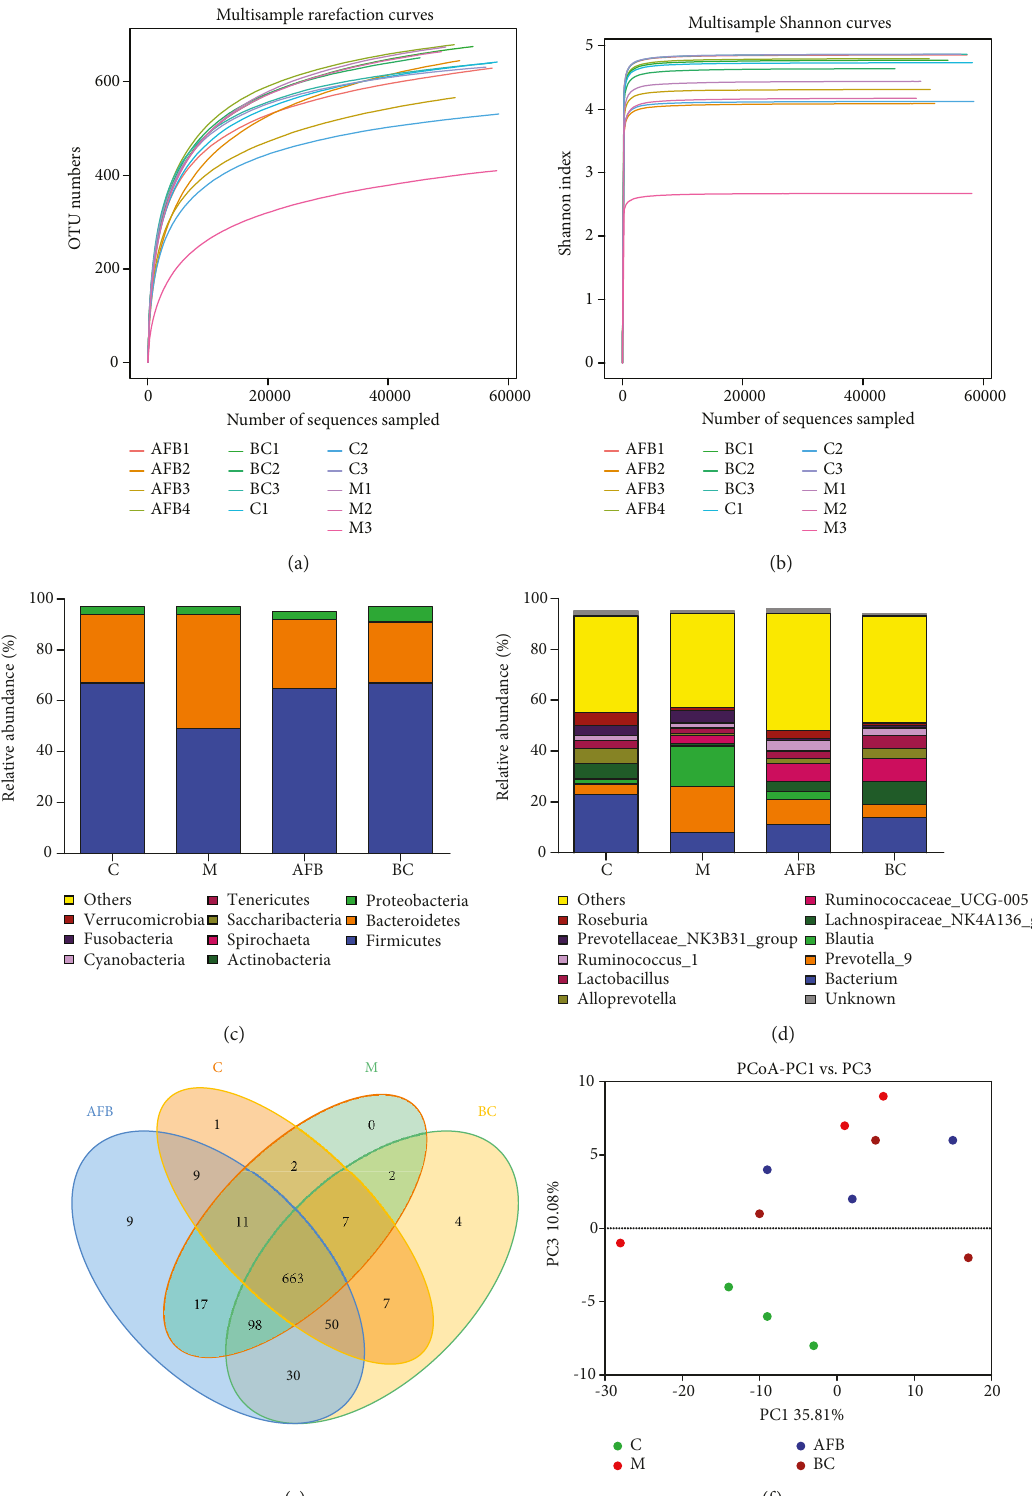
Figure 4: Evaluation of the aloe-fermented liquid on intestinal microbiota of burn rats using high-throughput sequencing: (a, b) the Shannon and rarefaction index among groups C, M, AFB, and BC; (c) the relative abundance of the bacteria among groups C, M, AFB, and BC at the phylum level; (d) the relative abundance of the bacteria among groups C, M, AFB, and BC at the genus level; (e) Scalar-Venn representation of the intestinal microbiota among the C, M, AFB, and BC groups; (f) the PCoA analysis of the C, M, AFB, and BC groups. C, control group; M, model group; AFB: aloe-fermented liquid group; BC: burn cream